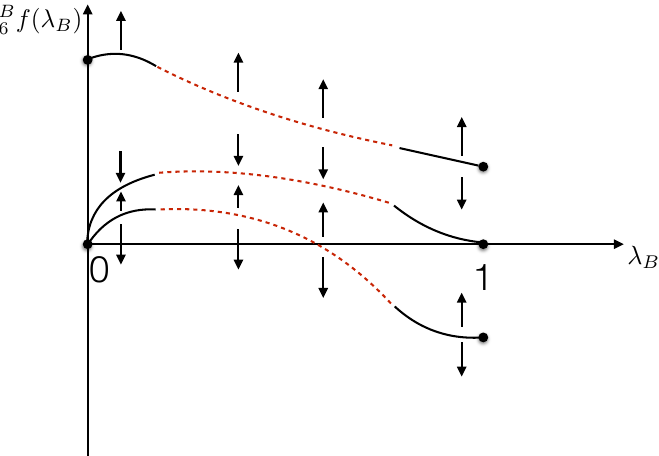
Figure 6. A schematic description of the large N RG (cid:13)ows towards low energies described in section 3.10. The vertical axis is x 6 multiplied by a convenient function of (cid:21) , that keeps the (cid:12)xed points at a (cid:12)nite separation both as (cid:21) B 0 and as (cid:21) F 0. The (cid:13)ows near the two limiting values ! ! of (cid:21) B (with the (cid:12)xed points depicted as solid lines) are based on computations, while the (cid:13)ows in the middle (with the (cid:12)xed points depicted as dashed lines) are conjectured, and it is possible that two of the lines actually meet and disappear for some value of (cid:21) B and then reappear at a larger